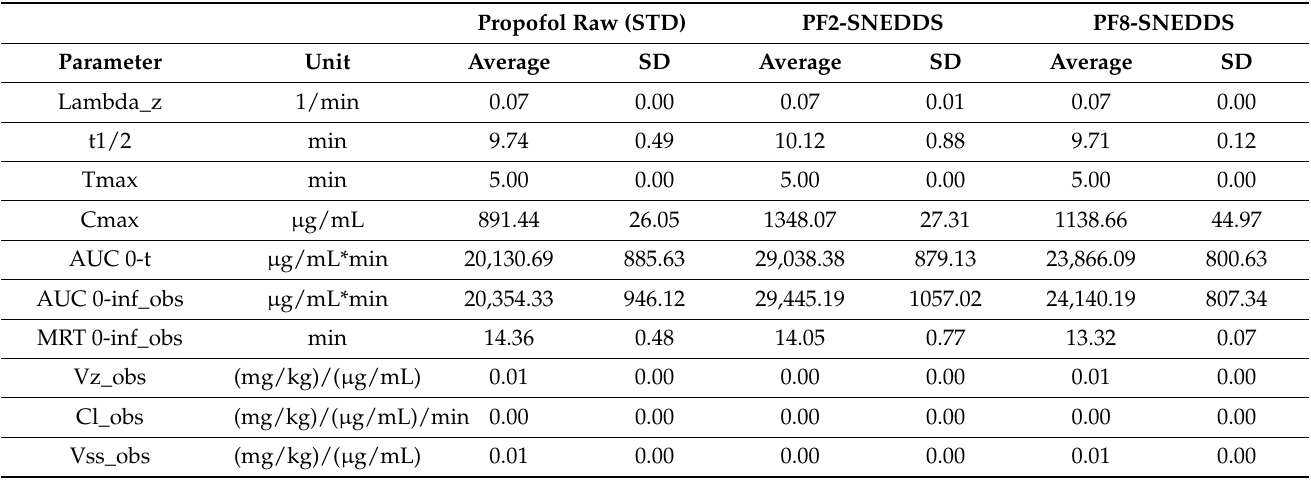
Table 9. Comparison of pharmacokinetic parameters of propofol formulation F2-SNEDDS